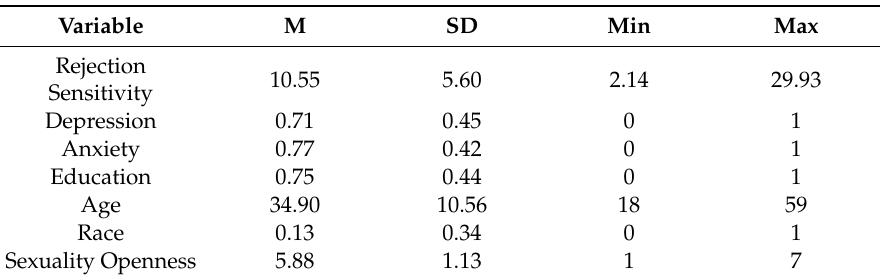
Table 2. Statistics.